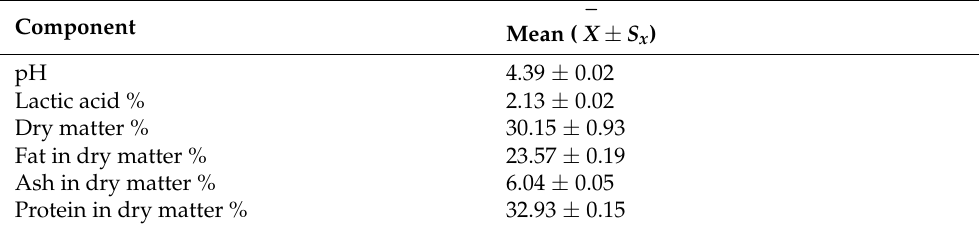
Table 1. Mineral salt used in Kurut production was purchased from a local market. Table 1. Characteristics of strained yogurt used in Kurut production.